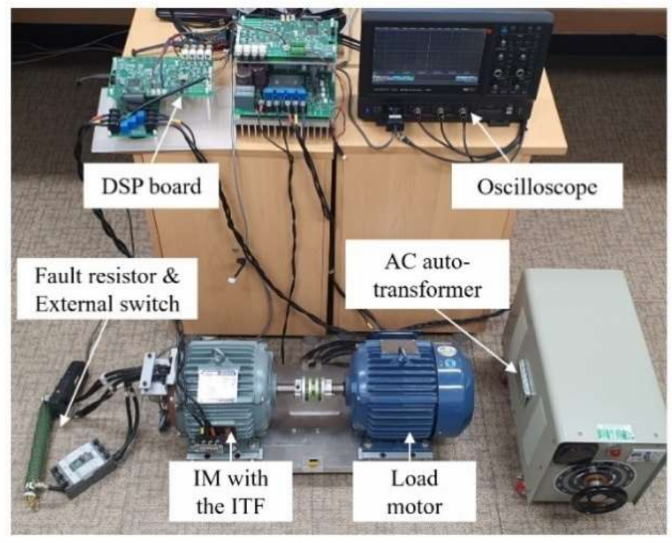
Figure 6. Experimental